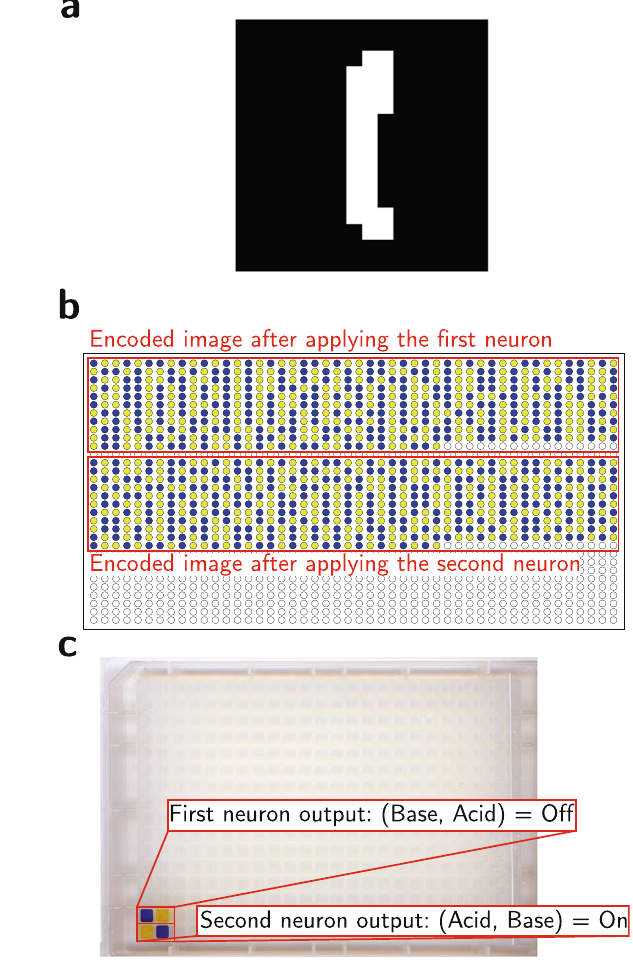
Fig. 6 | Classi fi cation of the digit “ 1 ” using an acid-base network. a The original 16×16 image to be classi fi ed. b The encoding of the image and inversions using acids(yellow) and bases(blue). c The fi nalclassi fi cation output image from the lab